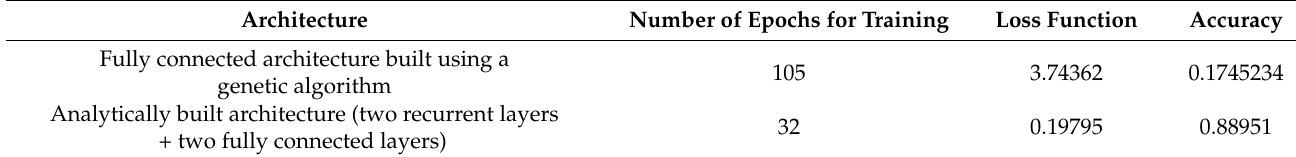
Table 3. Comparative characteristics of neural network architectures based on test data.